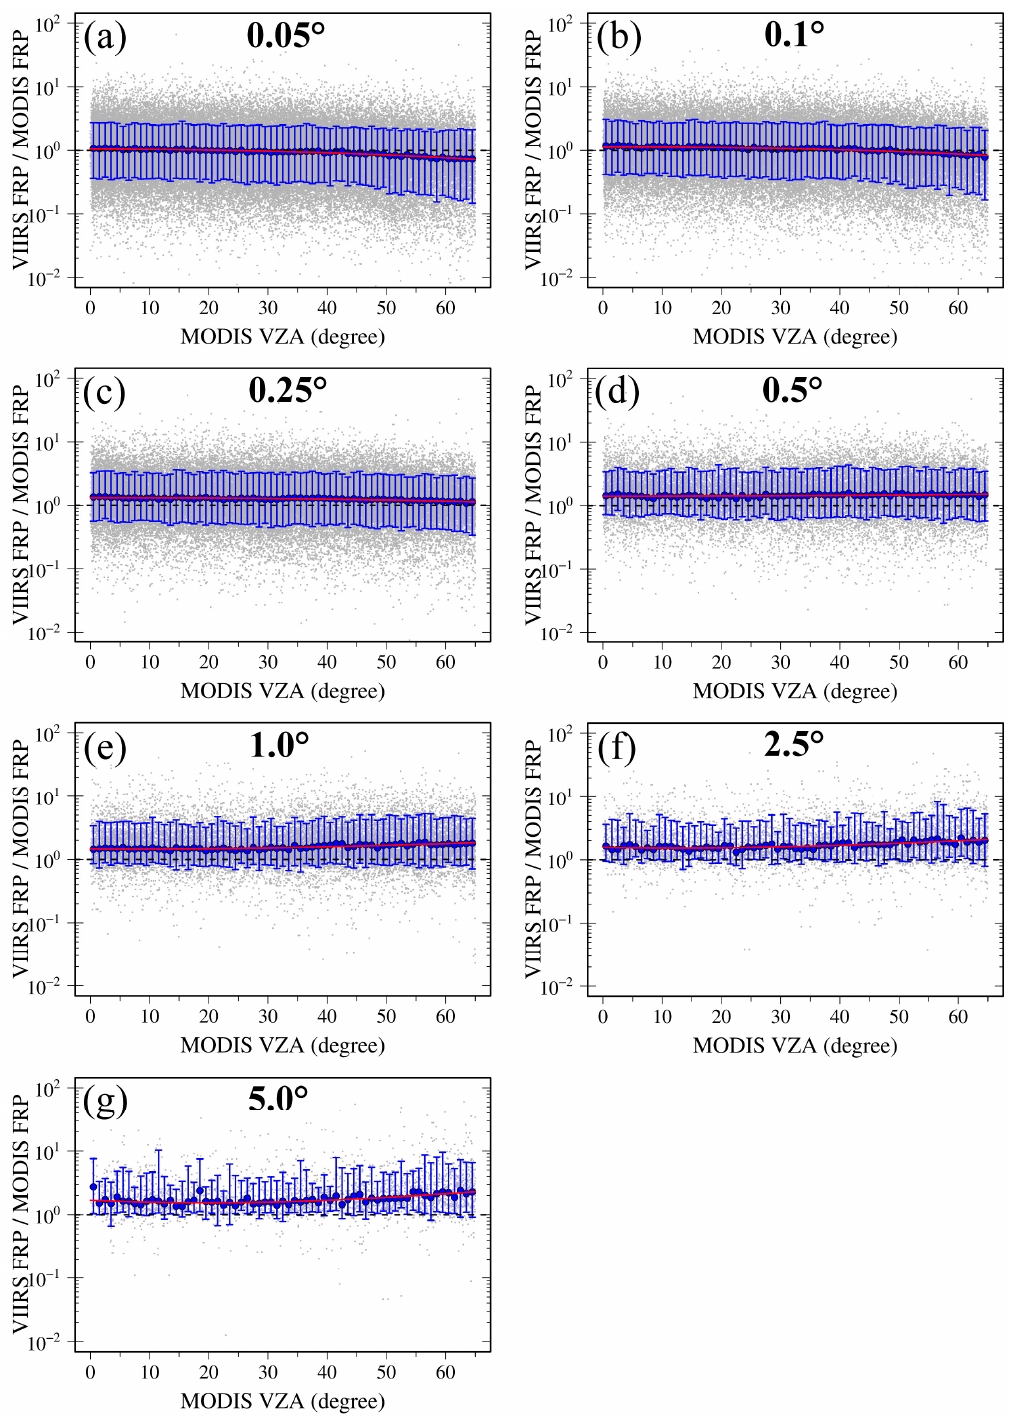
Figure 8. Derived best-fitted models (Equation (3)) at seven grid resolutions: ( a ) 0.05 ◦ , ( b ) 0.1 ◦ , ( c ) 0.25 ◦ , ( d ) 0.5 ◦ , ( e ) 1.0 ◦ , ( f ) 2.5 ◦ , and ( g ) 5.0 ◦ . Gray solid dots represent the matched grids, blue solid cycles and bars are the median, 10th, and 90th percentiles of the FRP ratio in every 1 ◦ MODIS VZA, and the red solid line is the best-fitted model. Note that the y -axis uses logarithmic scale for visualization purposes.